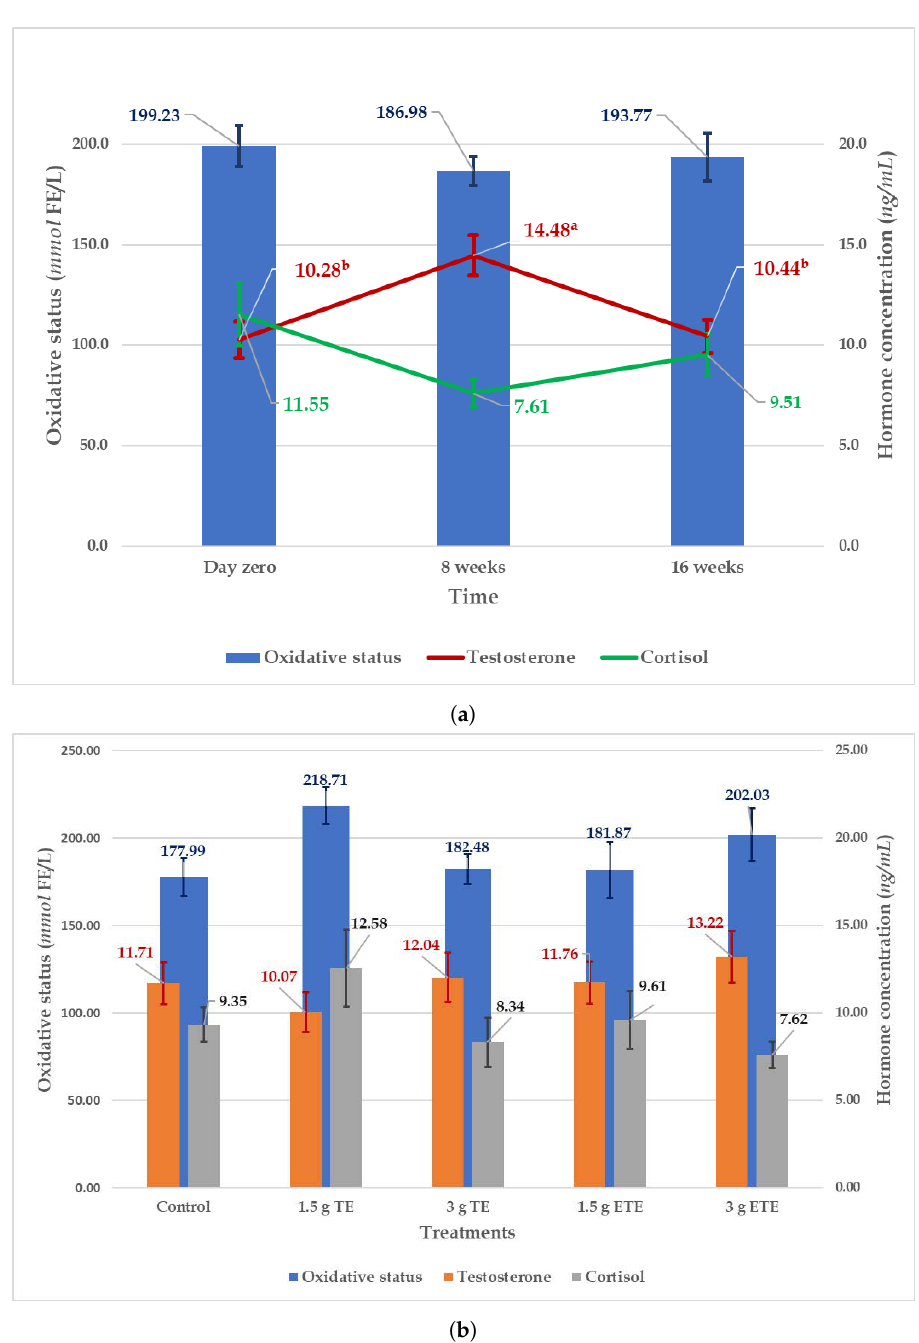
Figure 1. Effect of time ( a ) and supplementation treatments ( b ) on the hormonal and oxidative status (Mean ± SE) of South African Mutton Merino rams. a , b Means with different superscripts for the same parameter indicate significant differences ( p < 0.05). TE = tannin extract; ETE = encapsulated tannin